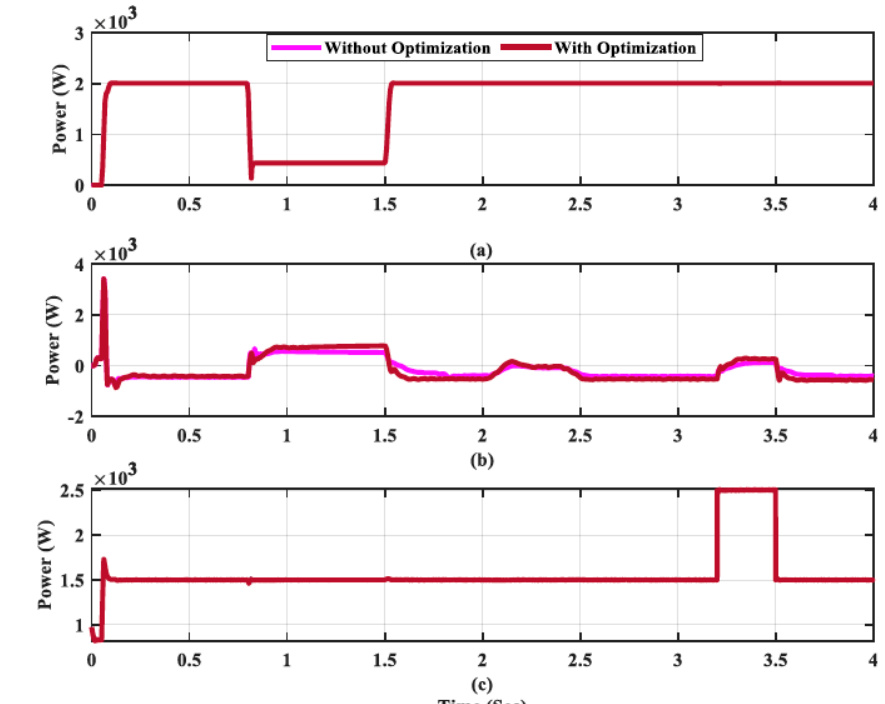
Figure 12. Hardware-in-the-loop equipment at our testbed.